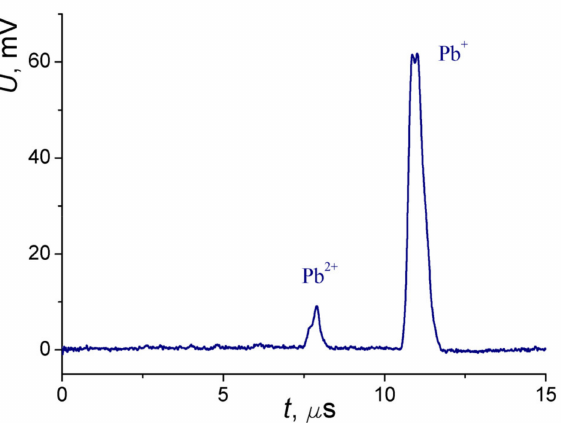
Figure 4. Time-of-flight ion spectrum of beam formed with a Pb magnetron target and a Pb vacuum arc cathode. Magnetron current is 5 A, arc current is 100 A, time delay after beginning of discharges is 100 µ